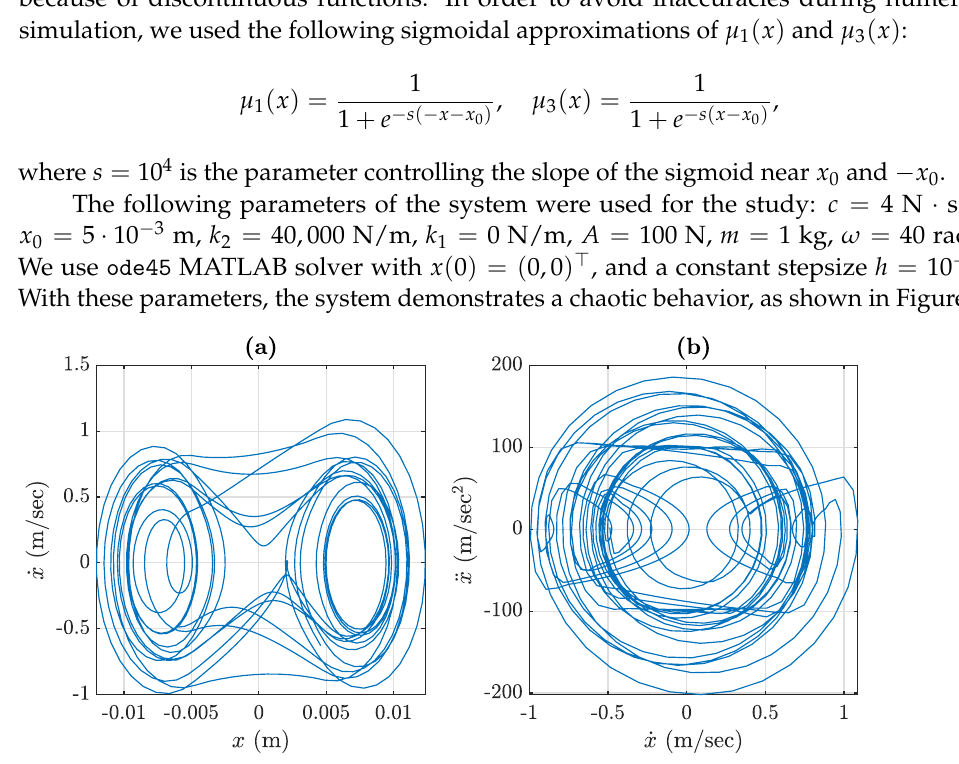
Figure 3. Phase space of the Lin-Ewins chaotic system: ( a ) the x - ˙ x phase space projection; ( b ) ˙ x - ¨ x phase space